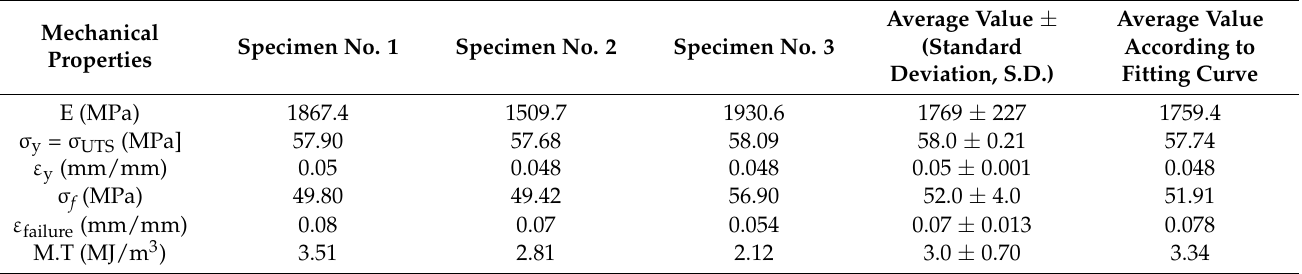
Figure 6. Engineering stress–strain curves for rectangular infill tested specimens. Table 2. Experimental results of mechanical properties for rectangular infill tested